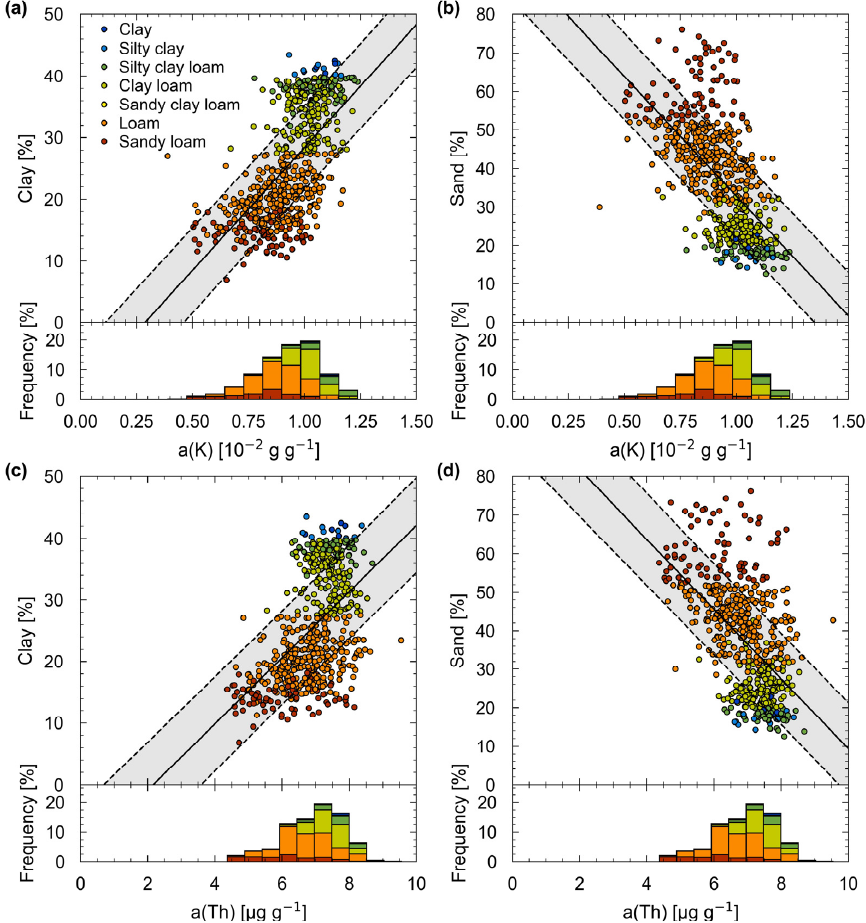
Figure 4. Correlation plots between ( a ) clay content and a(K), ( b ) sand content and a(K), ( c ) clay content and a(Th), ( d ) sand content and a(Th) of the training dataset (N = 578) paired with frequency distribution histograms of the corresponding radioelement abundance. Solid lines represent the SLR models with their 68% prediction level bands (gray).